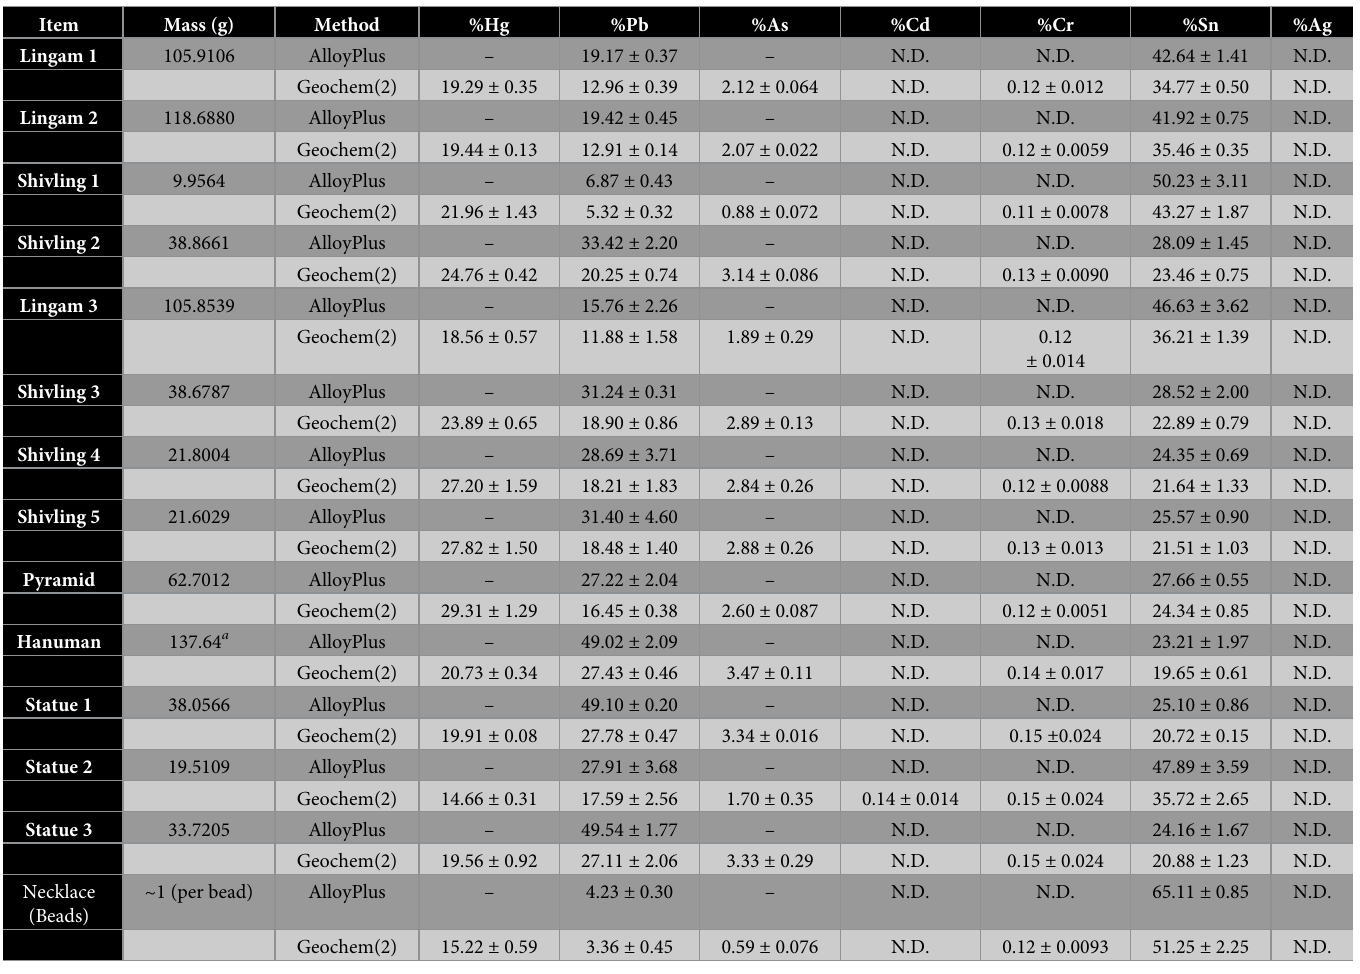
Table 1. Analysis of Parad Items by XRF (% ±